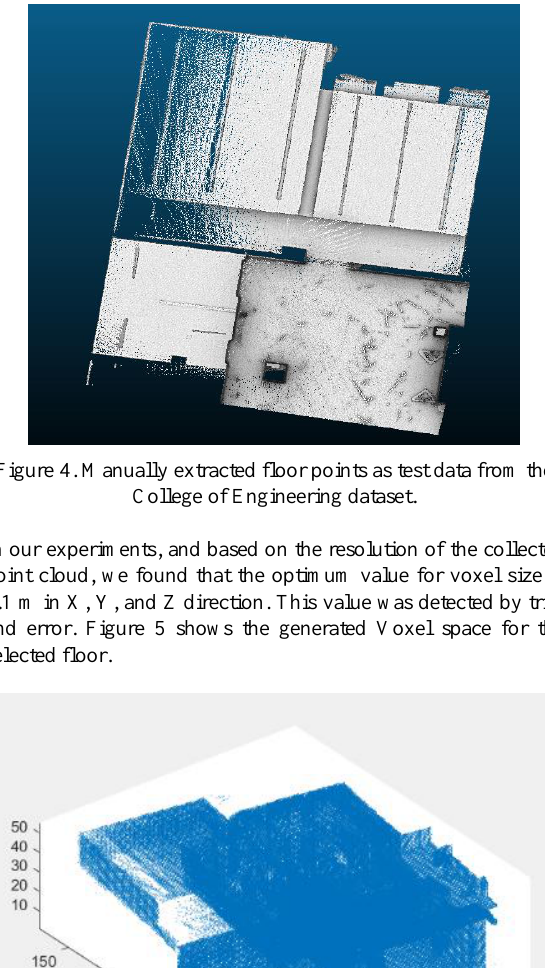
Figure 6, the offset solution with a distance of 30 cm below ceil has shown a better output. The extracted 2D points of the best section is shown in Figure 7.